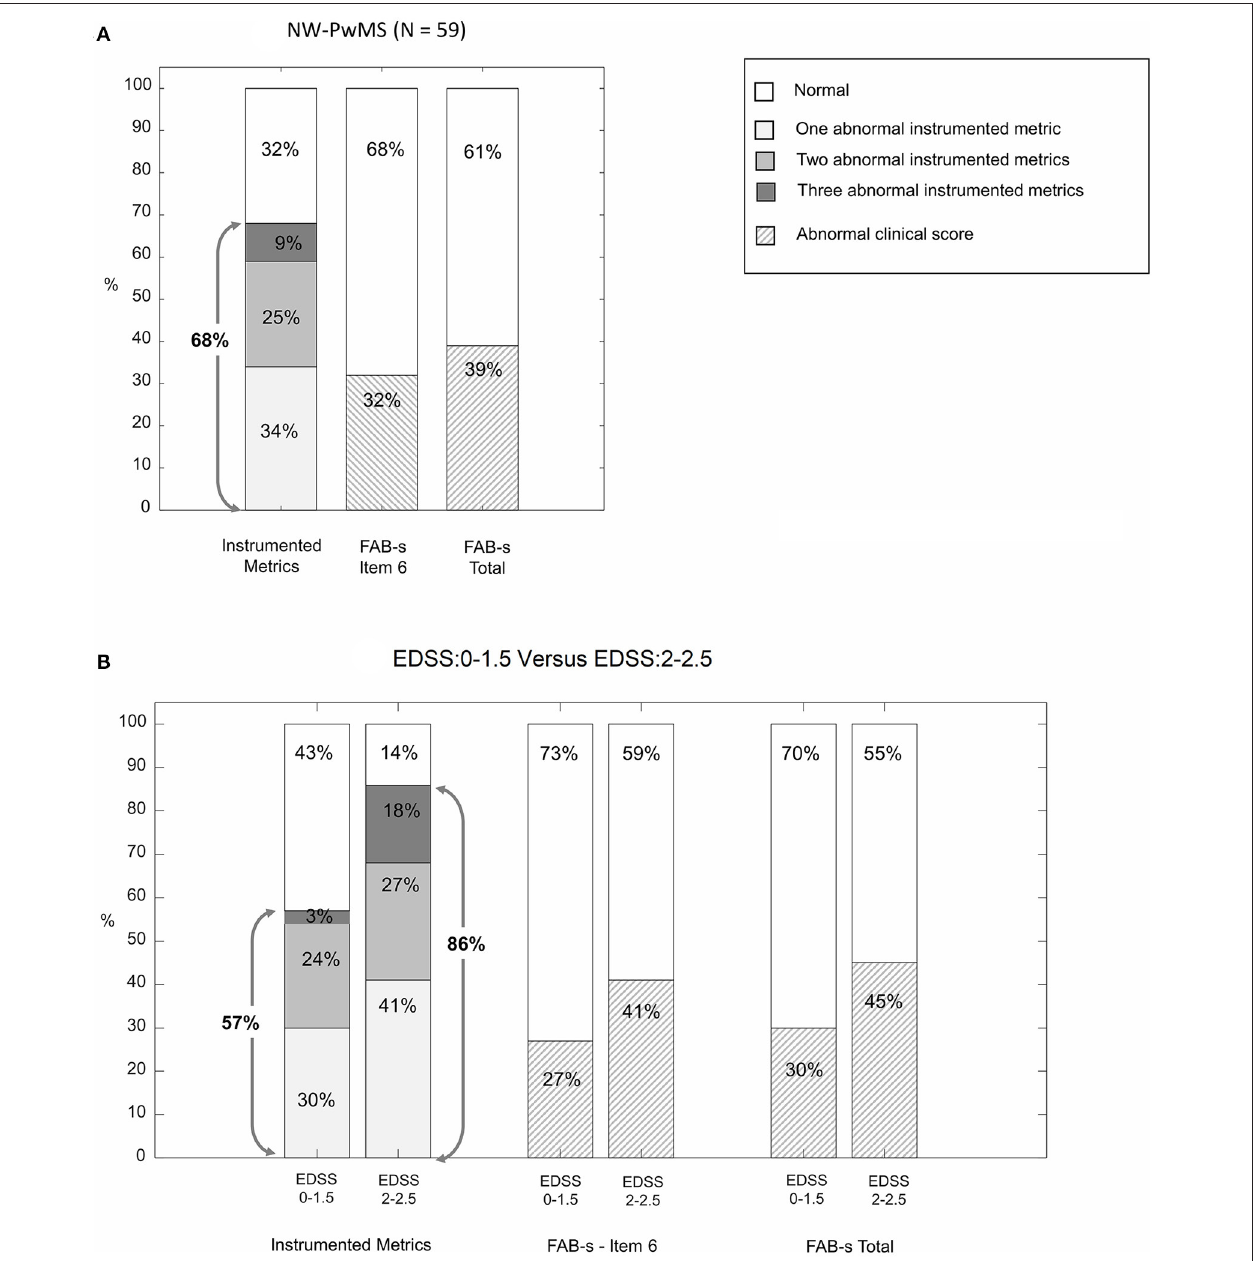
FIGURE 2 | Percentage of normal-walking people with MS (NW-PwMS) showing abnormal values of instrumented metrics descriptive of walking with horizontal head turns (WHHT) and abnormal clinical scores on FAB-s (Fullerton Advanced Balance scale-short version). (A) Whole sample of NW-PwMS. (B) NW-PwMS sub-samples showing, respectively, EDSS: 0–1.5 and EDSS: 2–2.5. Gray arrows indicate the percentage of NW-PwMS showing at least one abnormal instrumented